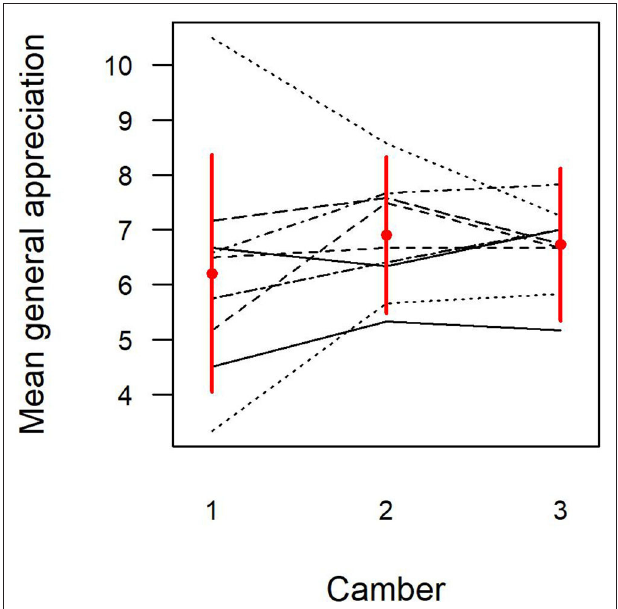
FIGURE 2 | Violinists’ bow appreciations—average overall appreciation according to camber (1, 2 or 3) and violinist. Lines connect the values for each individual violinist.